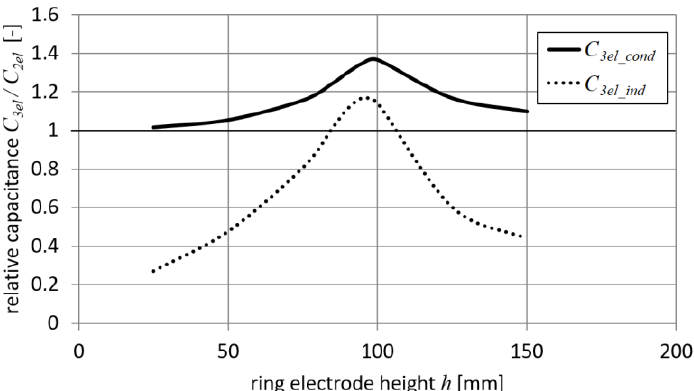
Figure 8. Droplet capacitance C 3 el values for induction and conductive charging methods, relative to the capacitance of the 2-electrode system C 2 el , as a function of ring electrode height h . Simulation parameters: r d = 40 mm, t d = 200 mm (i.e., narrow ring electrode and a big target). Results for a setup with a narrow ring electrode ( r d = 40 mm) and a small target ( t d = 20 mm)